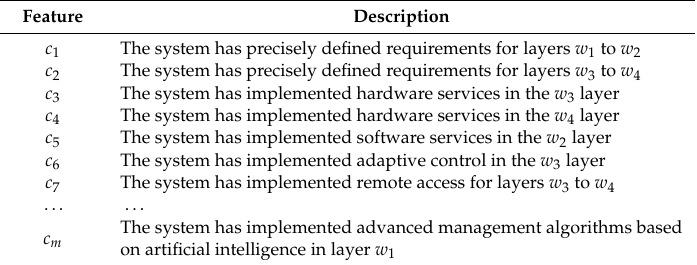
Table 1. Definition of the features of the example system.